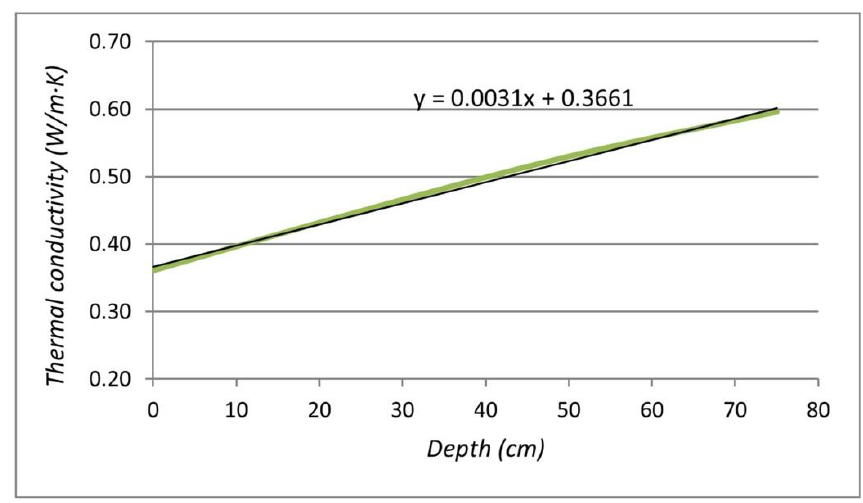
Figure 13. Relation between the thermal conductivity of the material and the depth where the parameter was measured.